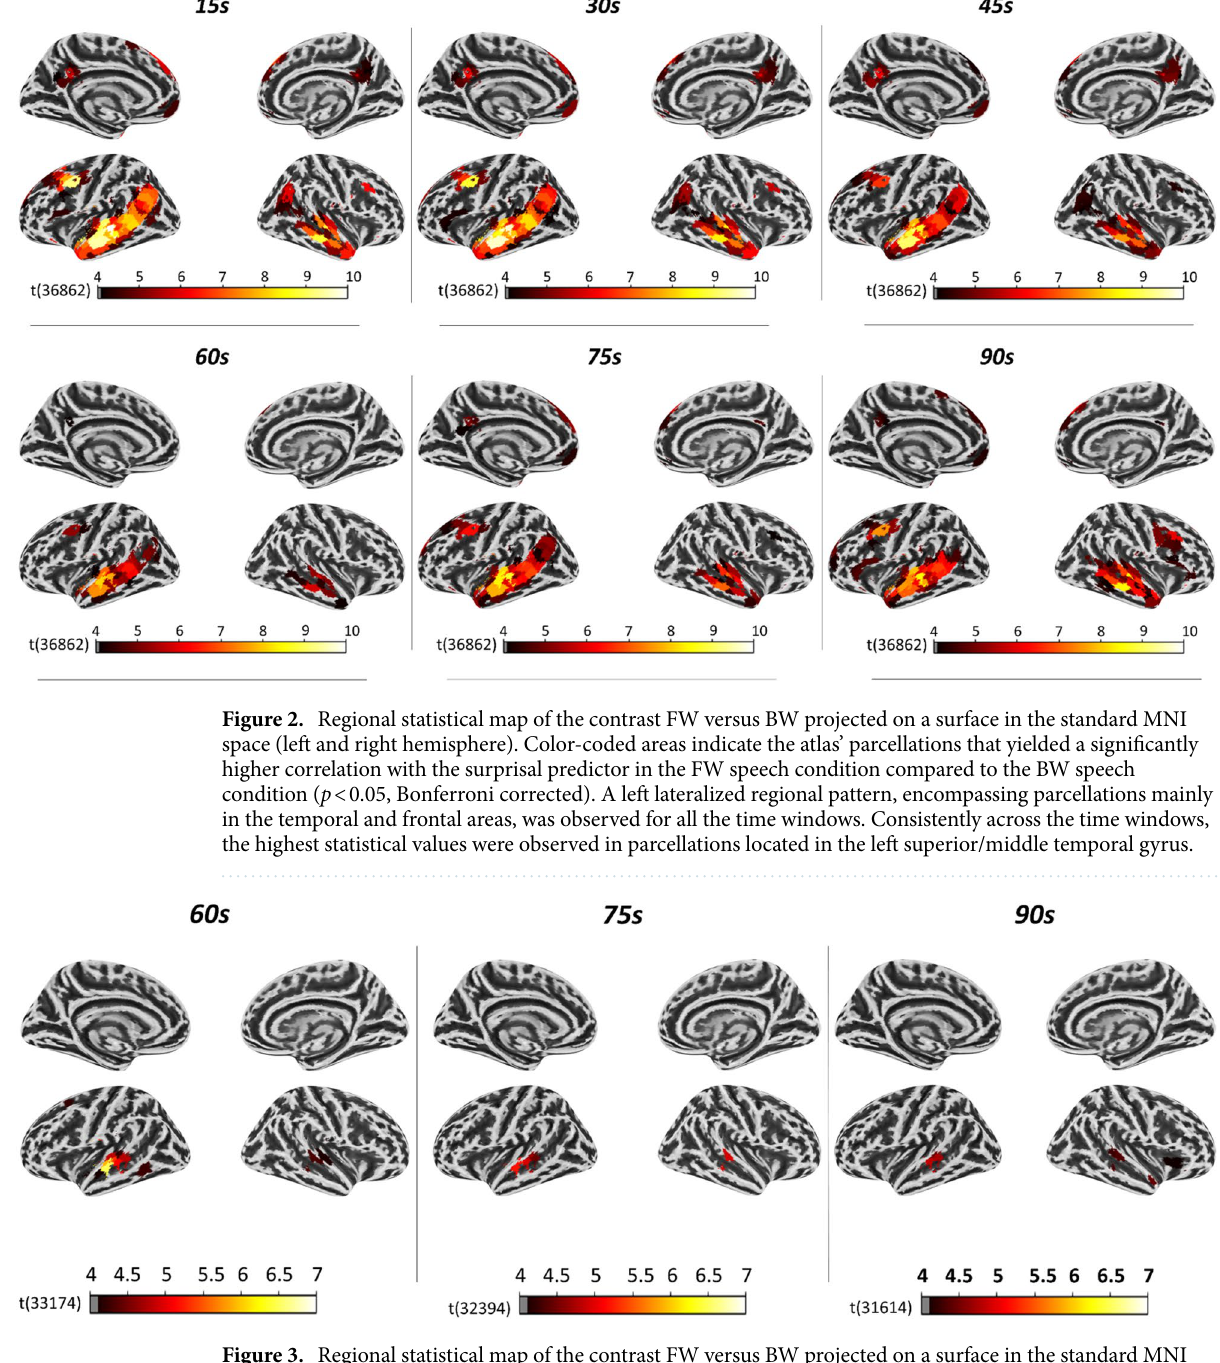
Figure 3. Regional statistical map of the contrast FW versus BW projected on a surface in the standard MNI space (left and right hemisphere). Color-coded areas indicate the atlas’ parcellations that yielded a significantly higher correlation with the saliency scores predictor in the FW speech condition compared to the BW speech condition ( p < 0.05, Bonferroni corrected). A left lateralized regional pattern, encompassing parcellations mainly in the temporal areas, was observed only for the three largest time windows (i.e., 60, 75, and 90 s), whereas no significant atlas’ parcellation was observed when considering shorter time window (i.e., 15, 30, and 45 s). Consistently across the time windows, where significant parcellations were observed, the highest statical values were elicited in regions located in the superior/middle temporal hosted in the superior and middle temporal areas. The fact that also the surprisal showed the strongest effects in these areas further supports the idea that context-related word evaluation promotes the neural encoding of word prediction where (and probably how) this takes place. In contrast to the surprisal analysis, the neural patterns associated with the saliency scores were not consist- ent across the six time windows.